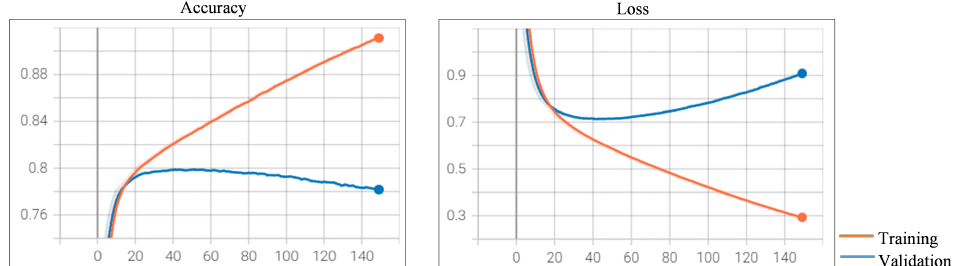
Figure 6. Performance of the improved transformers-base model. This model uses the Adam optimizer and a learning rate of 1 × 10 − 6 over 150 epochs. The other hyperparameters are set the same as the model built in the preliminary experiments.